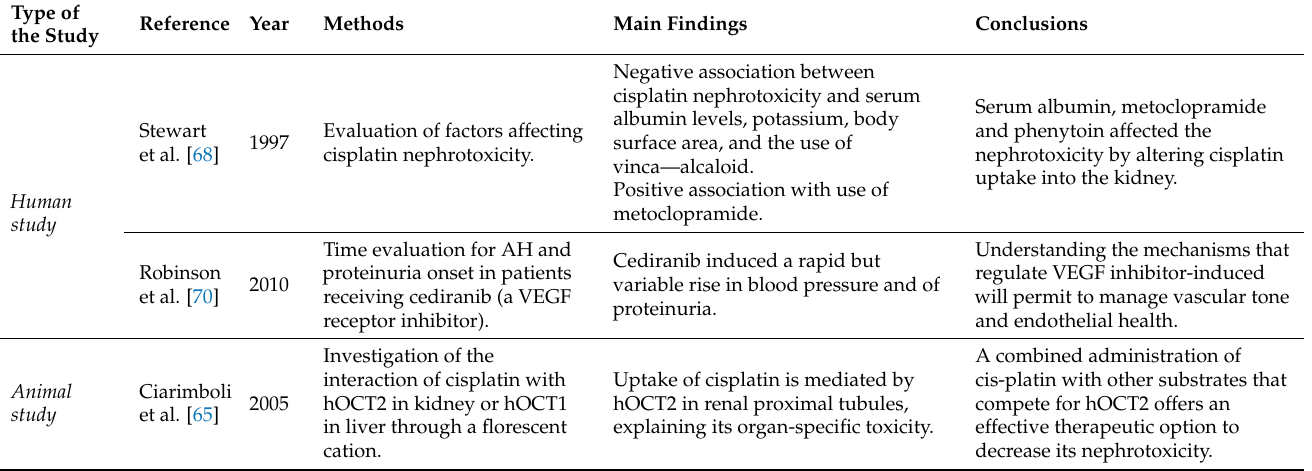
Table 2. Main studies on chemotherapeutic drugs and renal